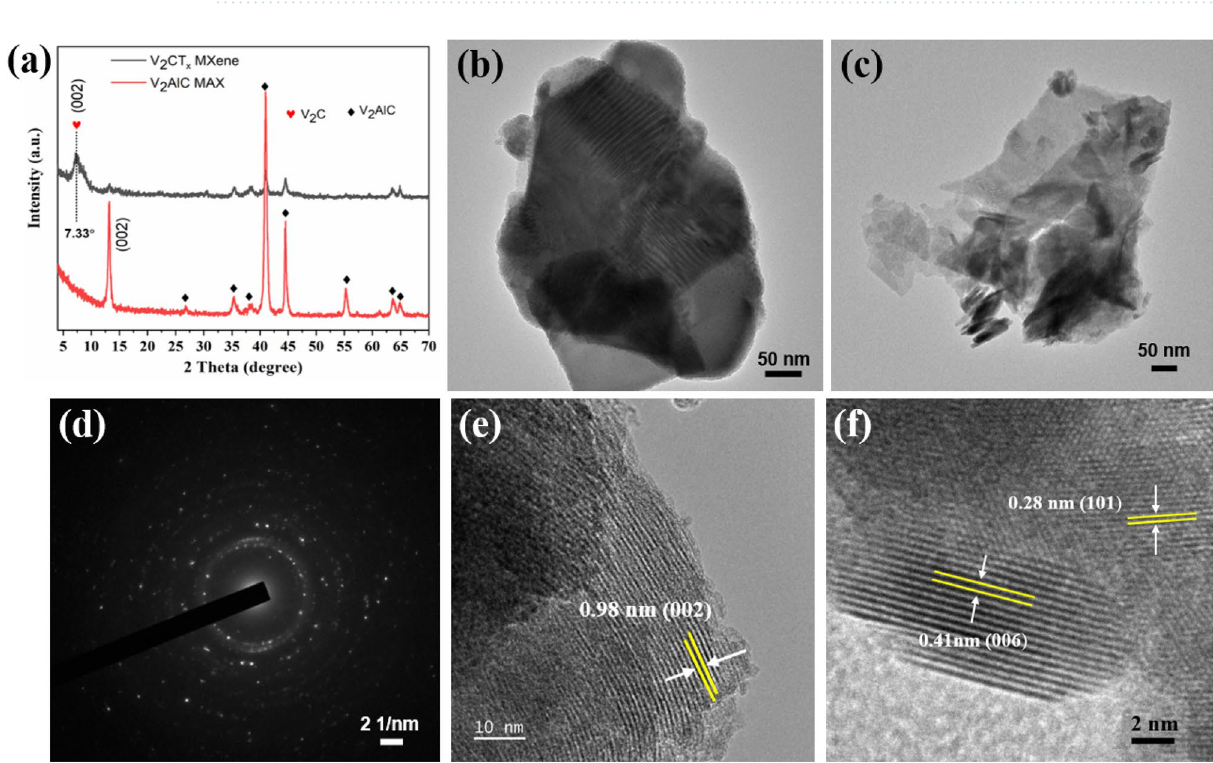
Figure 3. XRD pattern of V 2 AlC MAX-phase powders versus V 2 CT x MXene ( a ), TEM images of V 2 CT x MXenes ( b , c ), SAED pattern ( d ), and ( e , f ) HRTEM image of V 2 CT x